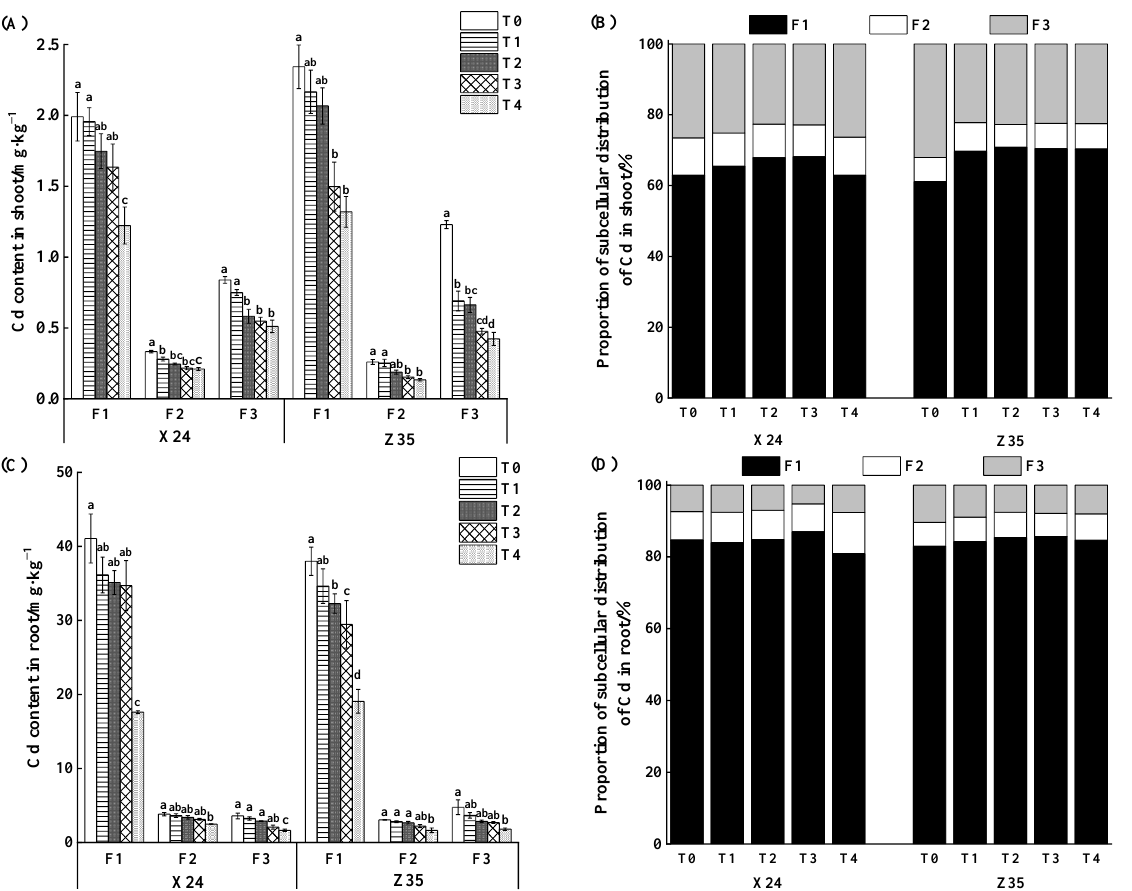
Figure 3. Effects of chlorinated amino acetic acid on cadmium concentration in shoot ( A , B ) and root ( C , D ) subcellular fractions of rice seedlings. T0, T1, T2, T3 and T4 respectively represent the application of 0, 0.2, 0.5, 0.8 and 1.2 mmol·L −1 chlorinated amino acetic acid treatment. Different lowercase letters indicate significant differences between treatments ( p < 0.05).